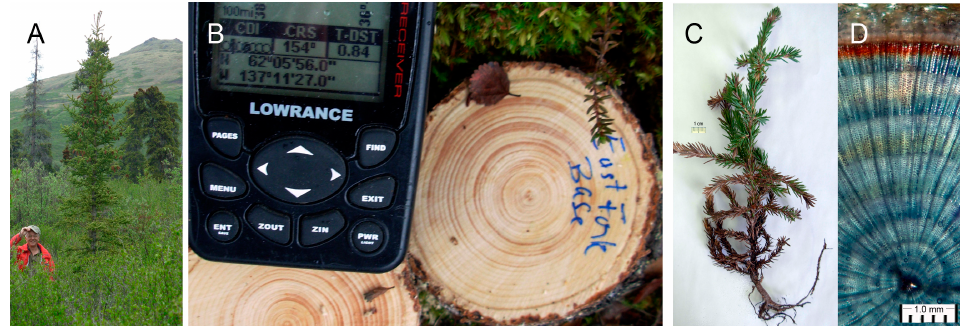
Figure 10. ( A ) The tallest (ca. 6 m) sapling found on site in June 2007 is beside the man and was growing at 1254 m asl, 250 m N of East Fork Creek. ( B ) A view 10 cm above the root collar of the tree shown in ( A ); its age is estimated at ~30 years. ( C ) A 23-cm-tall seedling found at 1470 m asl, and ( D ) a section near the seedling’s root collar showing 9 xylem layers (no chemical fixative; the orange zone comprises dead cambial derivatives ). Stained with 0.05% ( w / v ) toluidine blue O (see [22]).